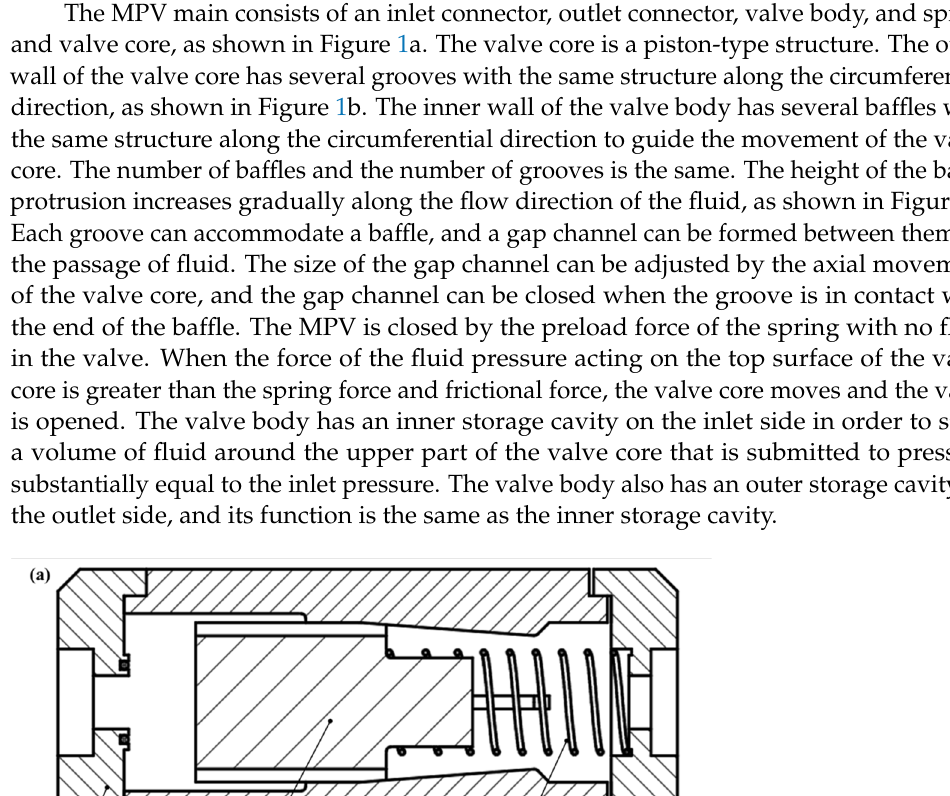
where (cid:52) p = P out − P in refers to the pressure drop between the inlet and the outlet of MPV, R h refers to the flow resistance of MPV. It can be seen from Equation (1) that, when the pressure gradient δ p (i.e., inlet pressure) increases, the flow resistance δ R h increases. At low pressure, the MPV has a constant and low flow resistance, as shown in stage-I of Figure 2b. When the pressure drop is beyond a threshold pressure (cid:52) p 0 , the flow